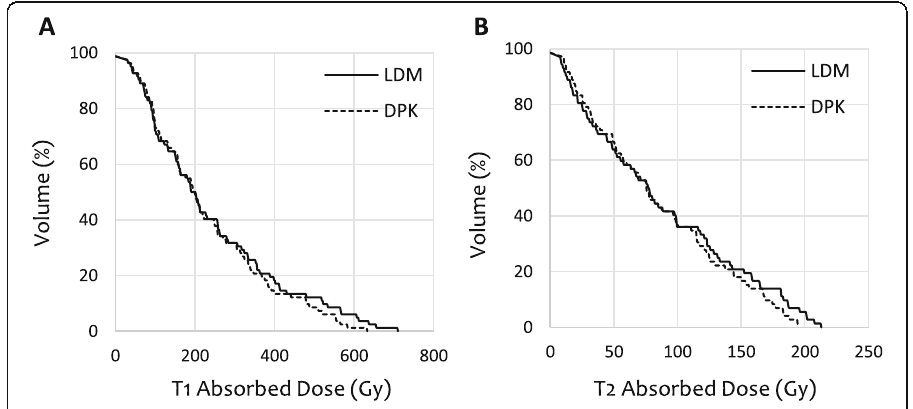
Fig. 9 Dose volume histogram curves for each individual tumor, corresponding to T 1 of patient 9 a and T 2 of patient 10 b . LDM dosimetry method is represented by continuous lines and DPK method with the dashed